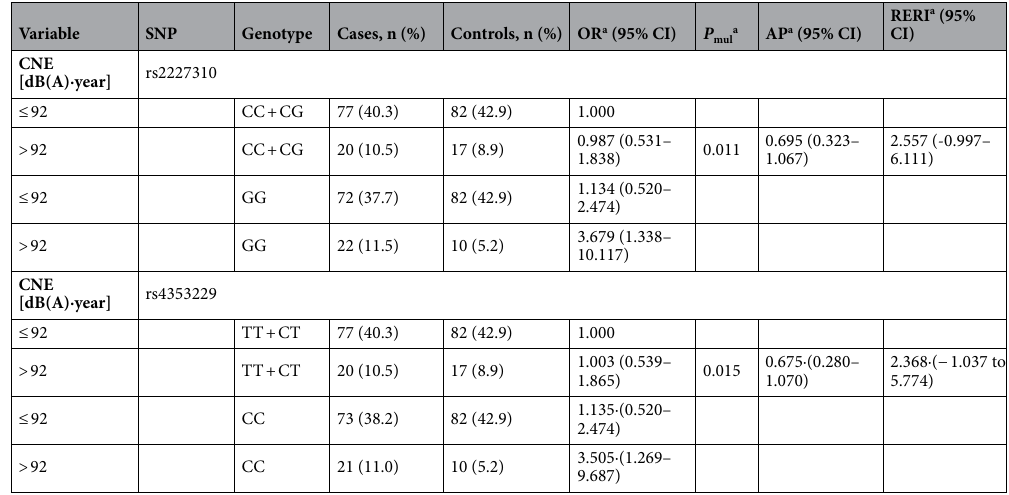
Table 3. The risk analysis of the occurrence of NIHL by the interaction between GASP7 gene SNP and cumulative noise exposure. P mul it was calculated using the product interaction term in Logistic regression analysis. a Adjusted for age, marital status, personal monthly income, noise exposure time, wear noise protection products, smoking frequency, drinking frequency, diet taste, wear headphones to listen to music/ watch videos, call time per day, length of one’s sleep, BMI, total cholesterol, triglyceride.